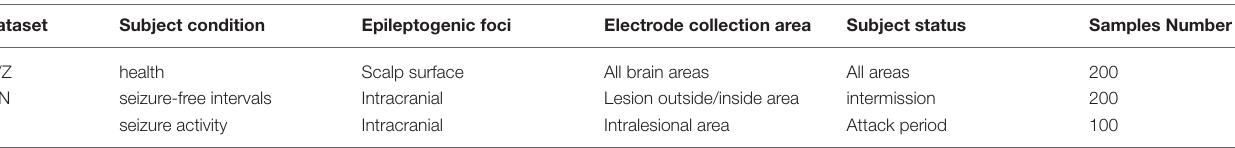
TABLE 1 | Description of real EEG